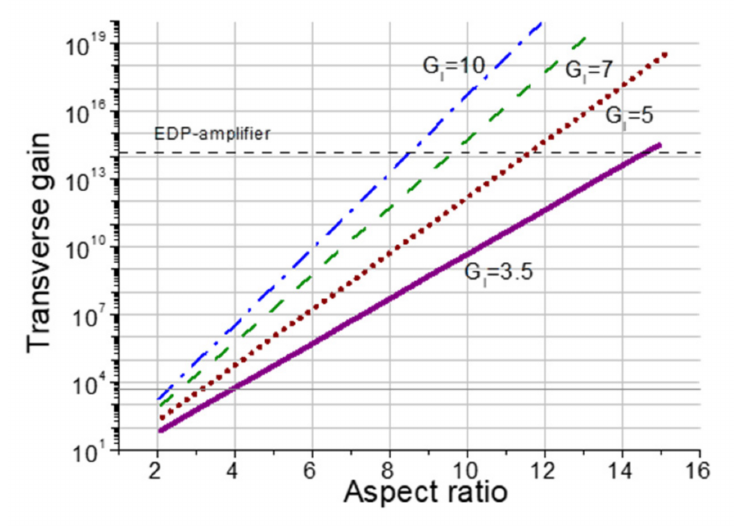
Figure 1. Dependences of transverse gain on crystal aspect ratios.